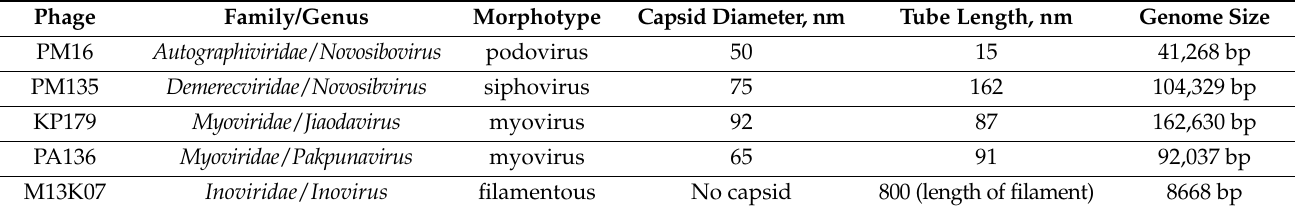
Table 1. Characteristics of the investigated